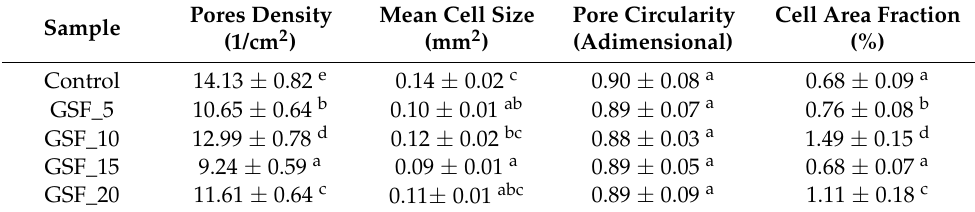
Table 6. Computed bread crumb characteristics.